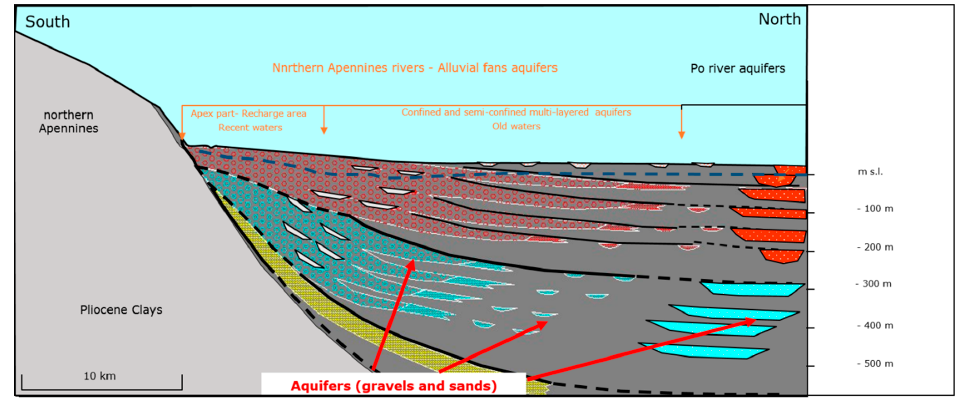
Figure 2. Simplified hydrogeological cross-section of a representative alluvial fan from the northern Apennines of Italy (modified after